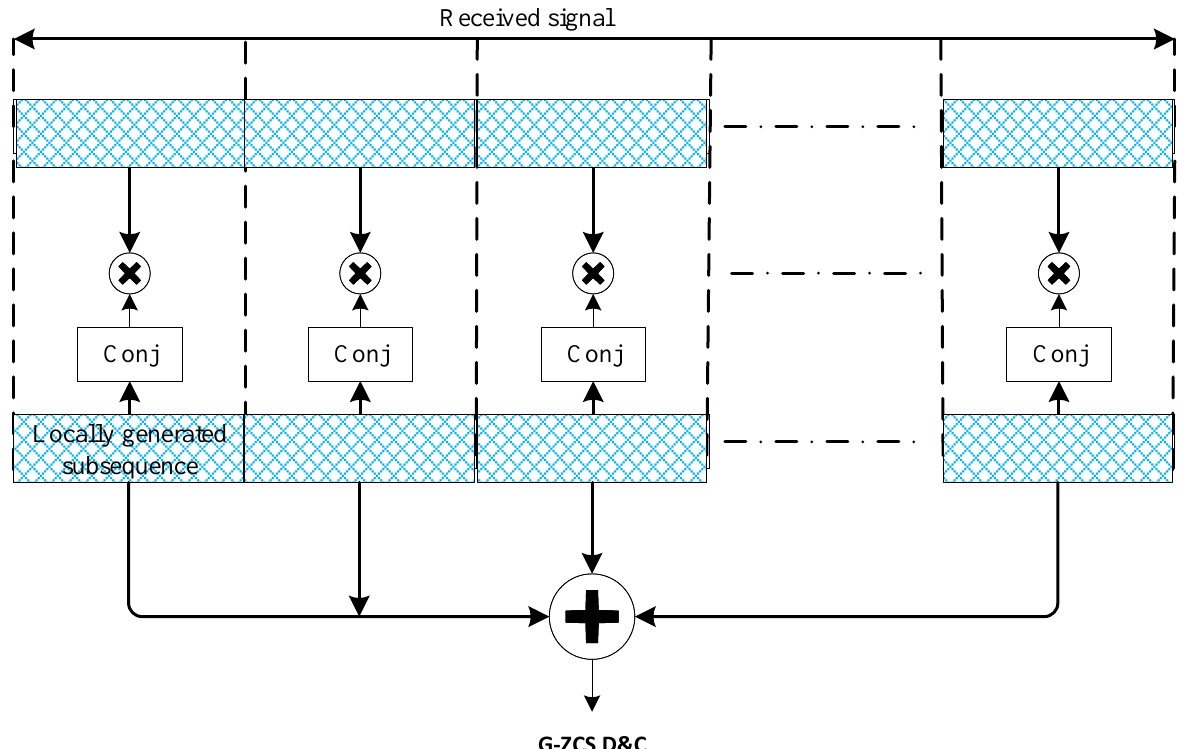
Figure 3. Decomposition and combining process for proposed